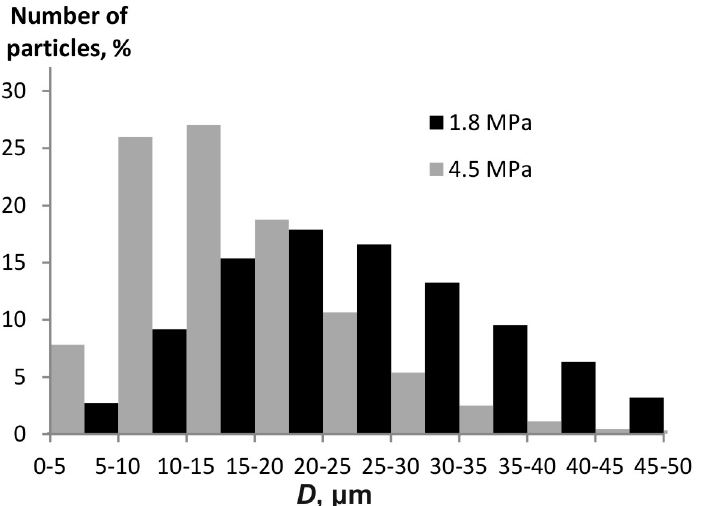
Figure 9. Histogram of the particle size distribution for a water aerosol at varying pressures in the pulse atomizer design.